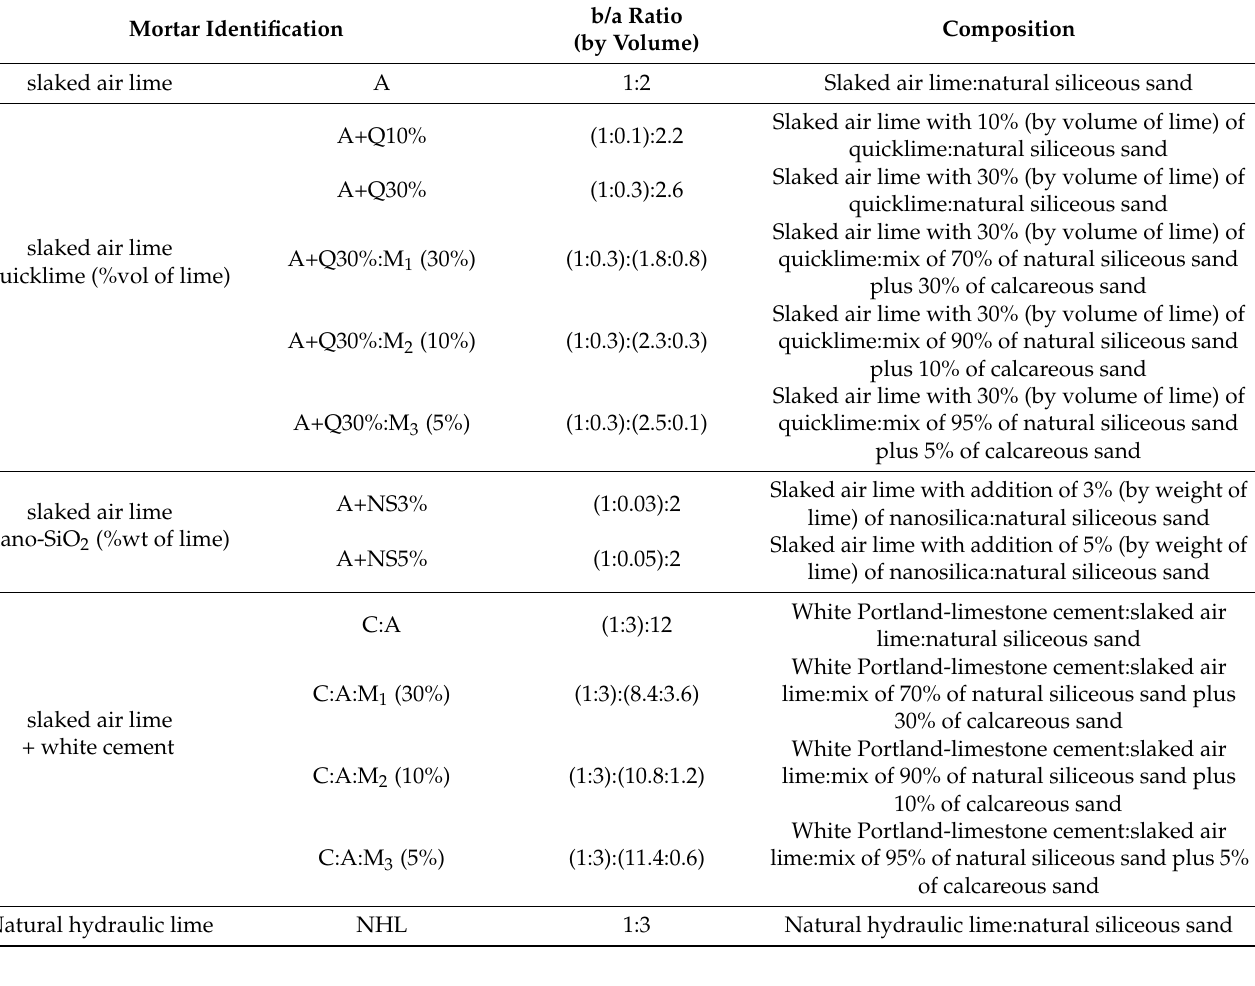
Table 2. Mortar compositions.